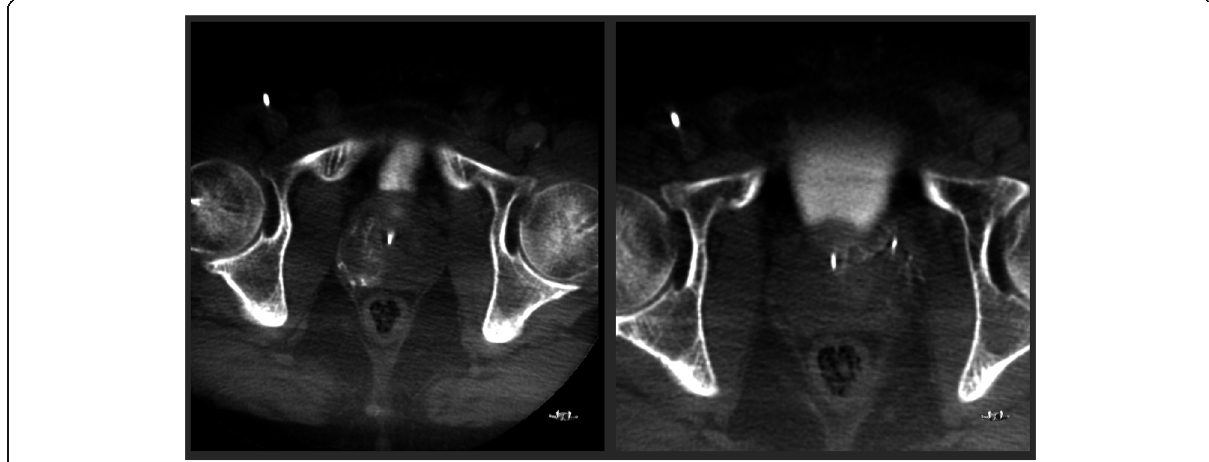
Fig. 2 Cone beam CT (CBCT) images from Patient 2 used for confirmation of microcatheter position show contrast enhancement in right (left panel) and left (right panel) prostate sides. No enhancement is seen in the neighboring